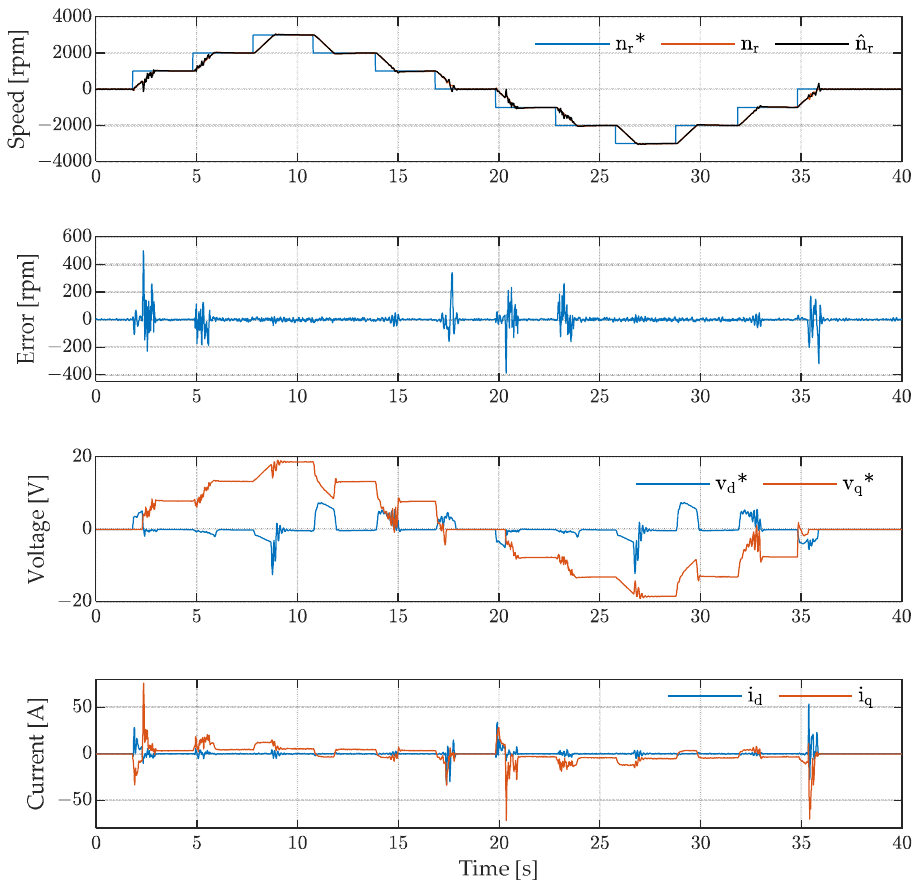
Figure 31. Speed profile up to nominal reference speed with no-load: speed, speed error, dq voltages, dq currents.